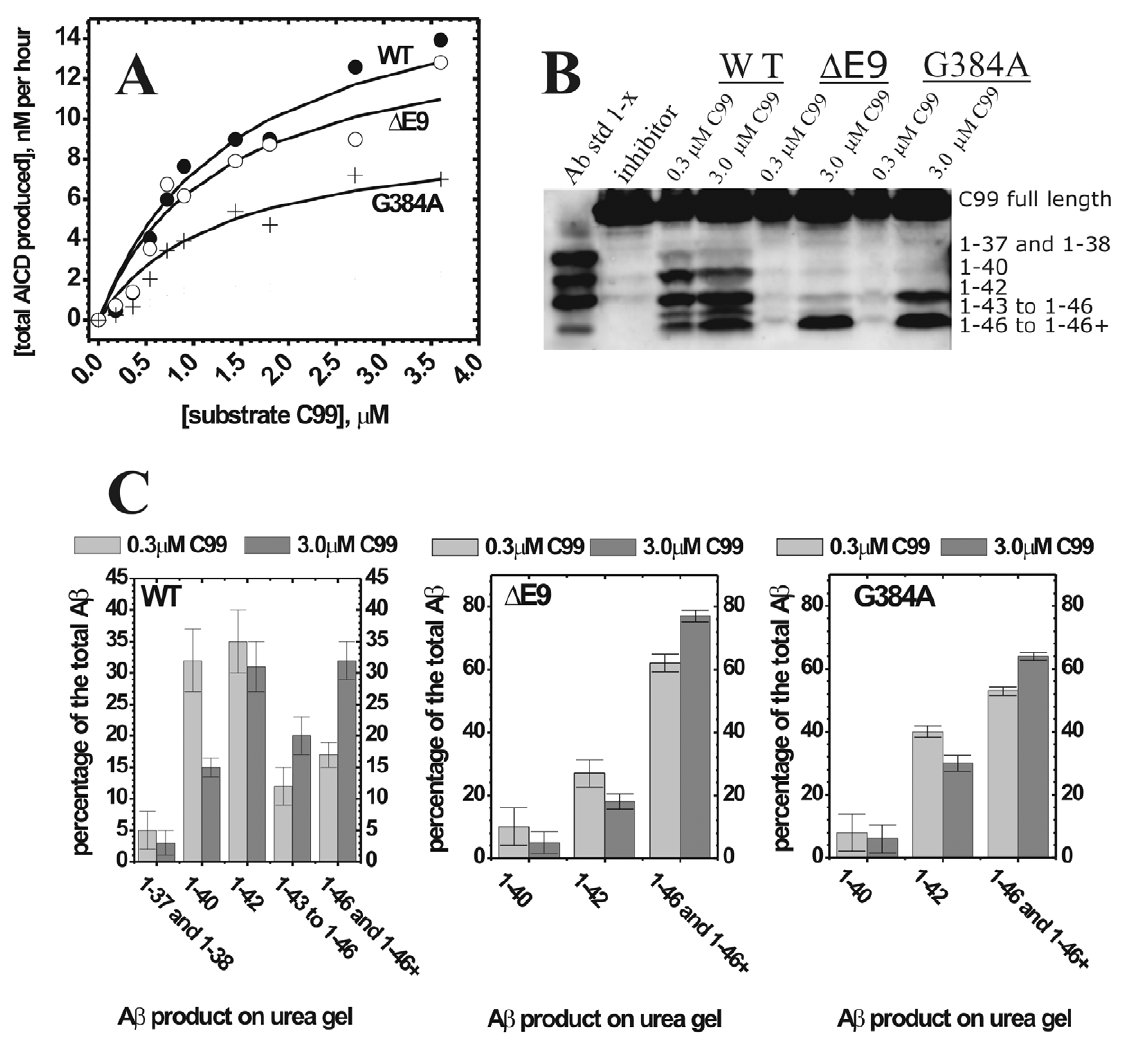
Figure 8. AICD and A b production by WT presenilin 1 and two FAD mutants. CHAPSO enriched c -secretase membranes carrying WT presenilin 1 or FAD mutants D E9 and G384A have been prepared and analyzed in parallel with all conditions identical. (A) Michaelis-Menten profiles for total AICD production (i.e. the turnover rates [37]) were measured in parallel using anti-flag a M2 antibodies as shown in Fig 3. (B) urea gels show the relative distribution of different A b 1-x products at the sub-saturating and saturating substrate concentrations (5 hour reactions). The lane ‘‘A b std 1-x’’ represents synthetic peptides as mobility standards, the lane ‘‘inhibitor’’ represents a parallel control reaction in the presence of 10 m M of c - secretase inhibitors DAPT and LY-411,575 [3,4] (C) The relative intensity of each A b 1-x peak is shown as a percent of the total sum of all A b peaks in the corresponding lane. The intensity of different A b 1-x products was quantified by transforming the individual bands into a series of peaks using the ‘‘ribbon option’’ in program ImmageQuant 5.0. The resulting peaks and the corresponding baselines were quantified using the ‘‘peak-fit’’ option in MicroCal Origin 7.0 program.